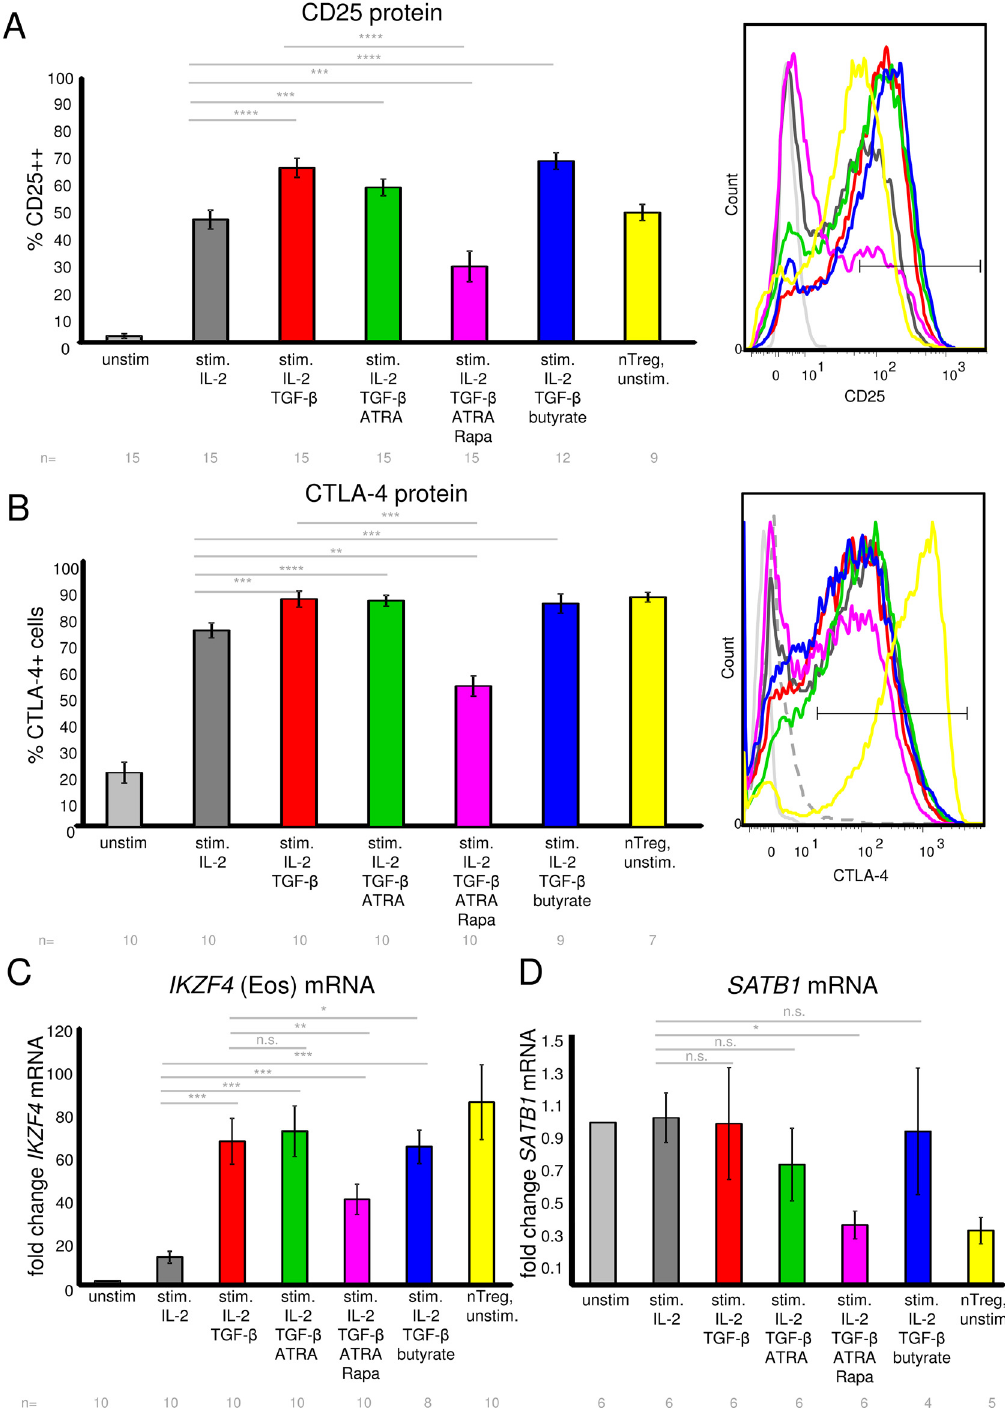
Fig 2. Expression of Treg signature molecules in human iTregs. (A) CD25 surface expression was measured by surface staining and flow cytometry on day 6 of culture under the indicated conditions, gated on live CD4+ cells. Shown are mean +/- SEM values for n = 9 to 15 donors (n number indicated below plot). Significance was calculated with paired t test. The right panel shows representative CD25 histogram overlays; color code as in the left panel. (B) CTLA- 4 expression (surface and intracellular) was quantified by staining of permeabilized cells and flow cytometry on day 6 of culture under the indicated conditions, gated on live CD4+ cells. Shown are mean +/- SEM values for n = 7 to 10 donors. Significance was calculated with paired t test. The right panel shows representative CTLA-4 histogram overlays; color code as in the left panel. Dashed line represents CTLA-4 isotype control (isotype example shown for